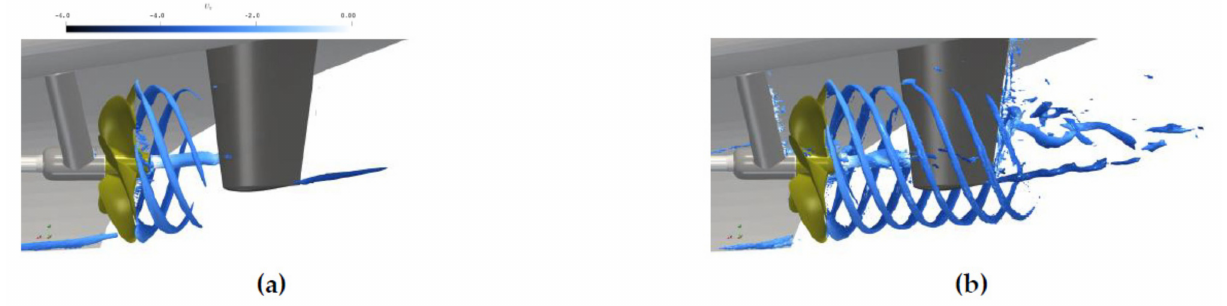
Figure 8. ProNoVi target case. Comparison of RANS and ILES Q-criterion Q = 5 · 10 4 s − 2 at model scale on the same mesh: ( a ) RANS; ( b )